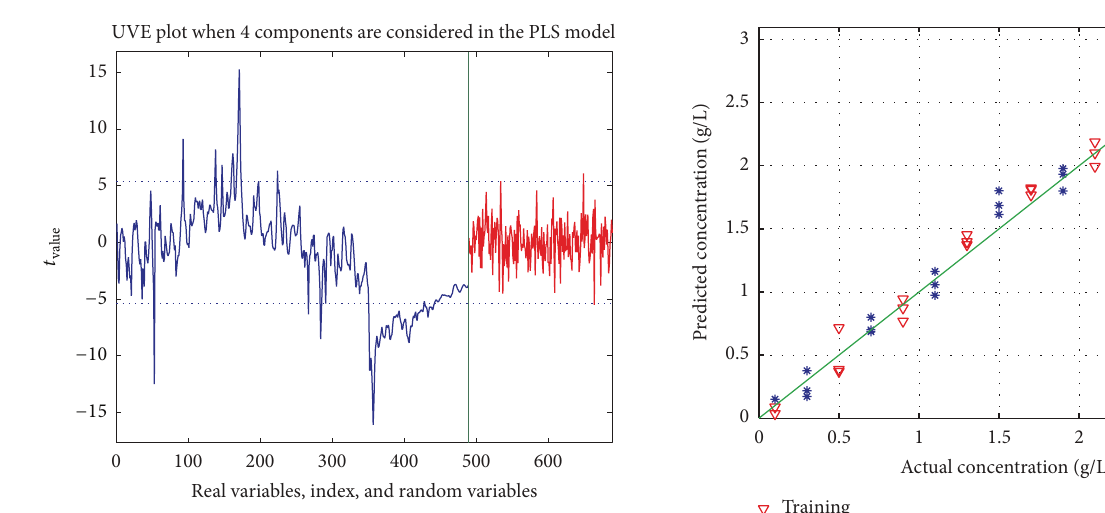
Figure 4: Plot of 𝑡 value for original wavenumber variables and artificial variables. The cut-off limit is indicated by the dotted lines.